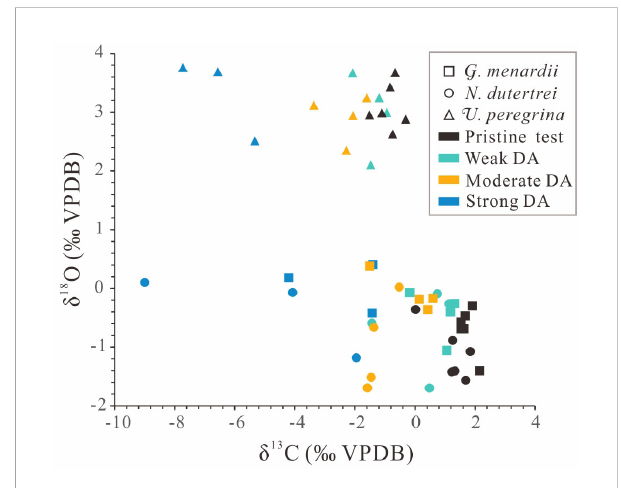
FIGURE 3 Carbon and oxygen stable isotopes of foraminiferal tests at variable diagenetic alteration stages. The squares, circles, and triangles represent the taxa G. menardii , N. dutertrei and U. peregrina , respectively; black, green, orange and blue represent pristine, weakly altered, moderately altered, and strongly altered tests, respectively.